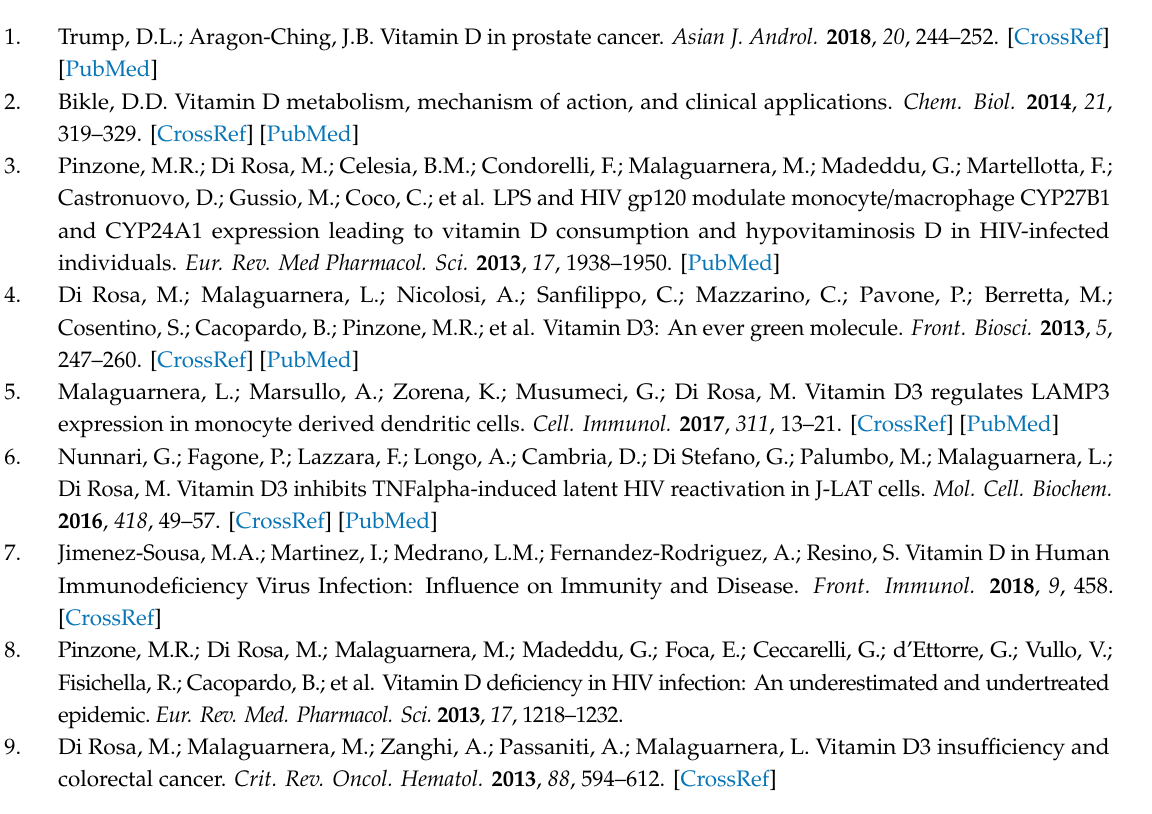
Figure S1: The six key genes expression levels in GSE70770, GSE62872 and GSE6919. Table S1: Contains the complete analyzes used for the realization of this manuscript. Table S2: The GeneMania-report of the 43 key genes